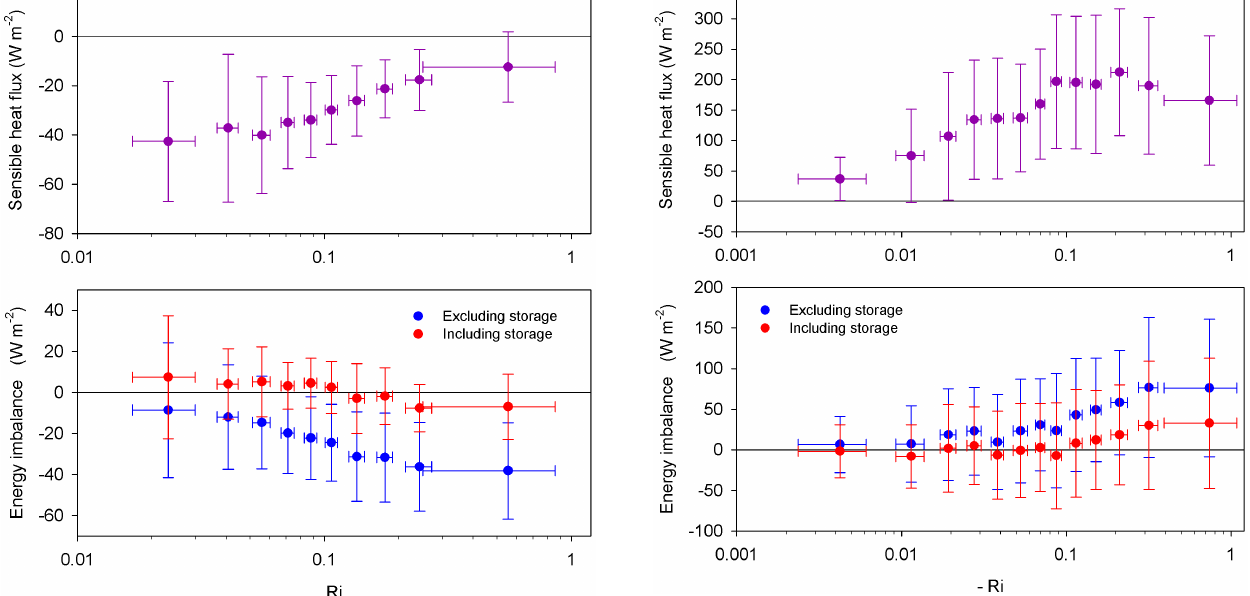
Fig. 9. Binned averages of sensible heat fluxes (top) and energy imbalance with and without storage (bottom) versus the Richadson number during stable conditions. Data from the whole period June– July 1995. Some data points representing extreme stabilities have been discarded.